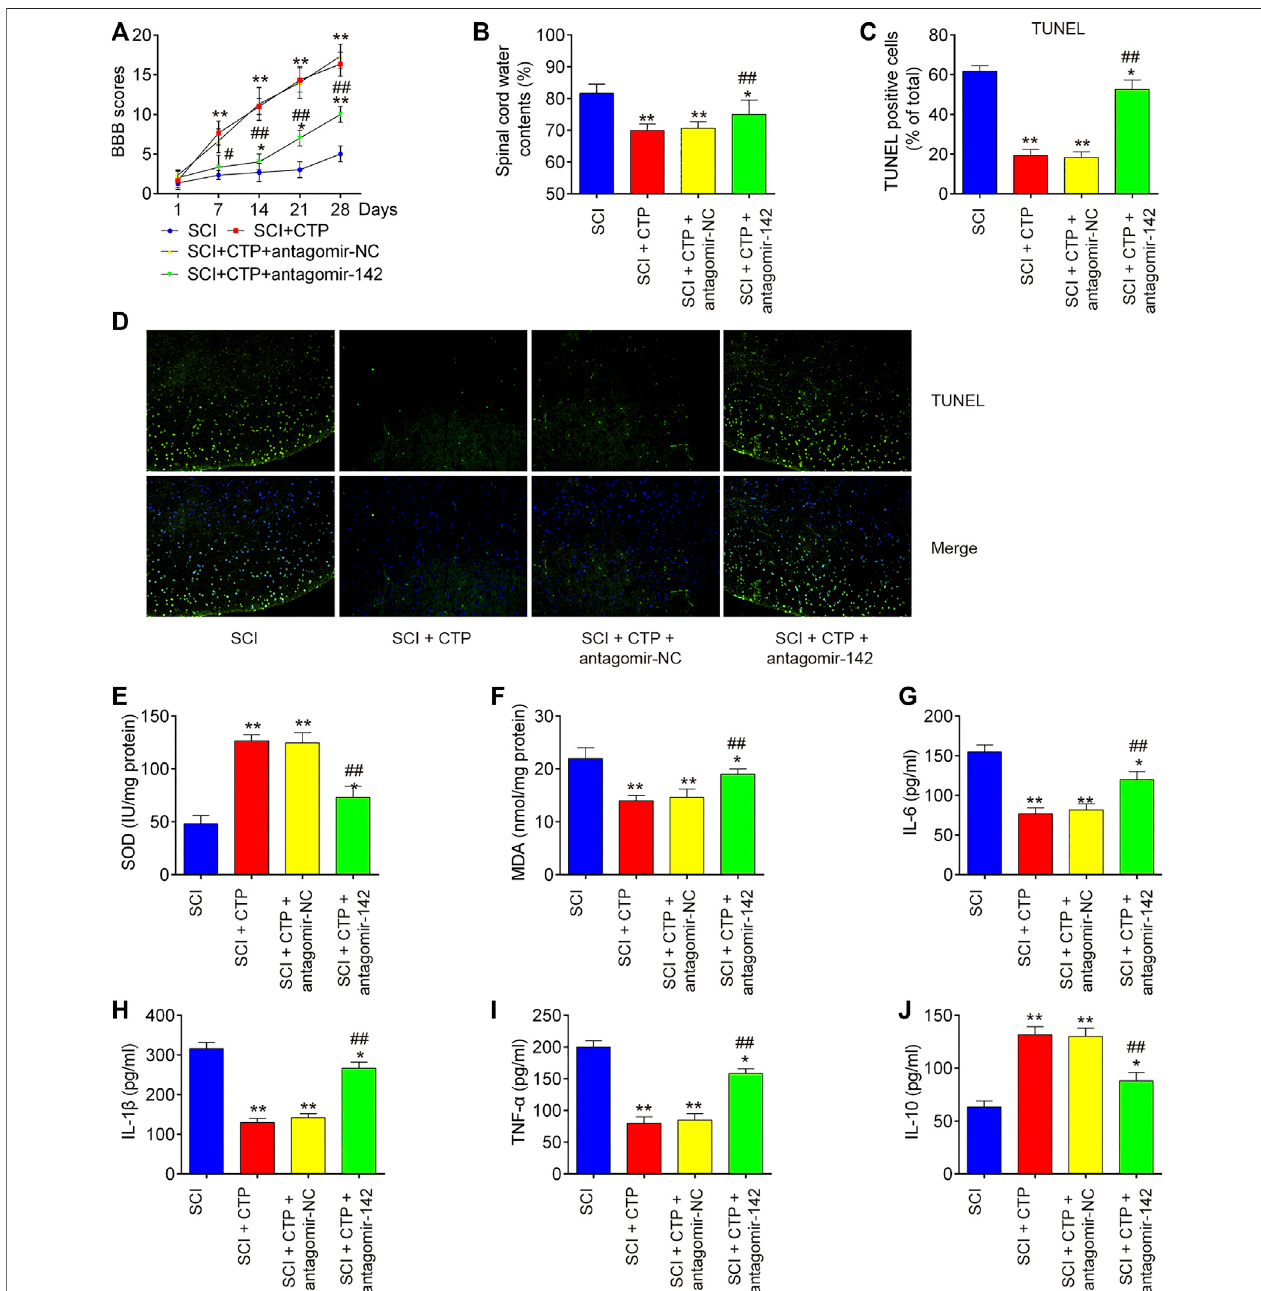
FIGURE 4 | Catalpol reduces the apoptosis, oxidative stress and in fl ammation in SCI mice through promoting miR-142. The mice were subjected to SCI and then treatedwith antagomiR-142/antagomir-NC viaintrathecalinjection for28 days starting15 minafter SCI. On thefollowing day after SCI, CTP wastreated tomice oncea dayfor4 weeksbygavage. (A) TheBBBscoresat1,7,14,21,and28 dayswereshownforallgroupsofmice. (B) Watercontentinspinalcordofmiceat28 dayspost- Catalpol treatment. (C and D) TUNEL staining of neuronal apoptosis. (E and F) The contents of MDA and SOD were measured by commercial kits. (G – J) The in fl ammatory cytokines including TNF- α , IL-1 β , IL-6 and IL-10, were evaluated by ELISA assays. Data represent the mean ± SD of three independent experiments. * p < 0.05, ** p < 0.01 vs. SCI group; ## p < 0.01 vs. SCI + CTP group.